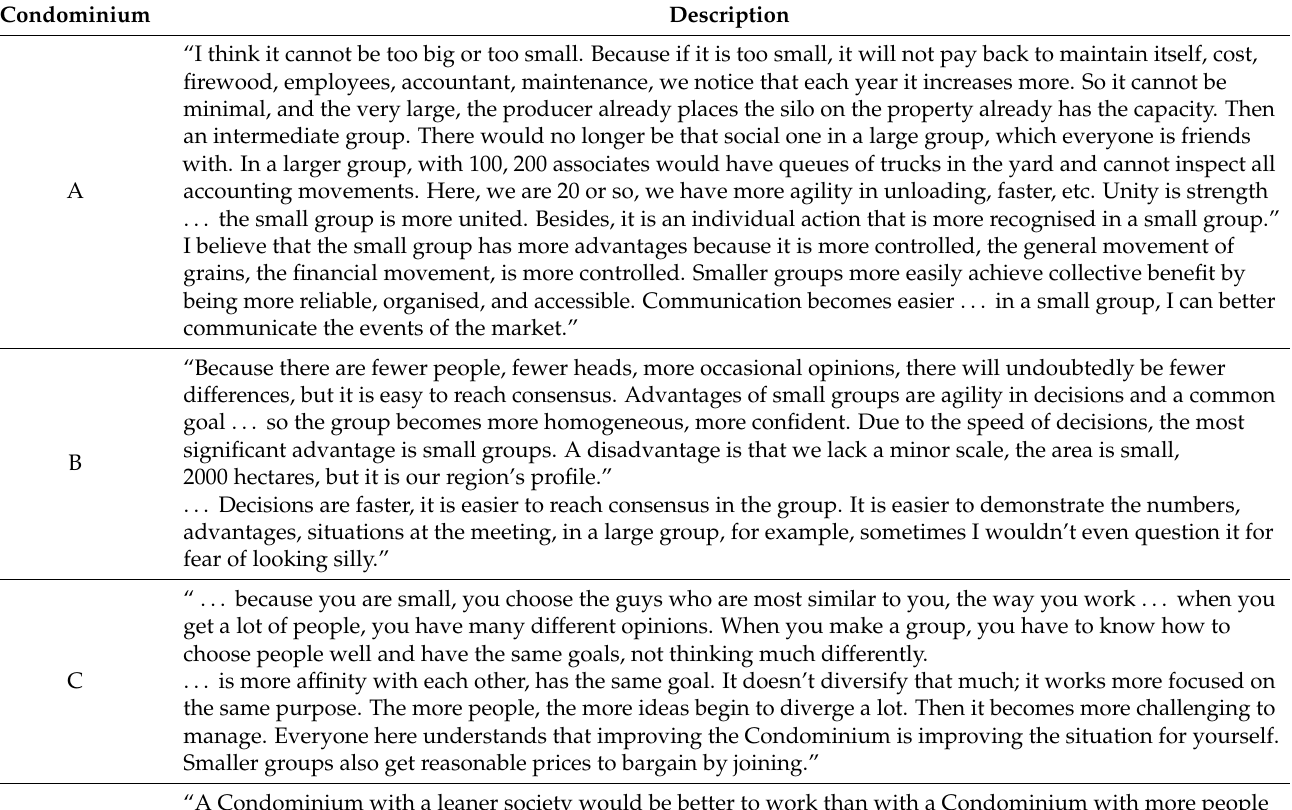
Table 5. Interviewees’ statements about the perspectives of the rural collective model Condominiums of Rural Warehouses in